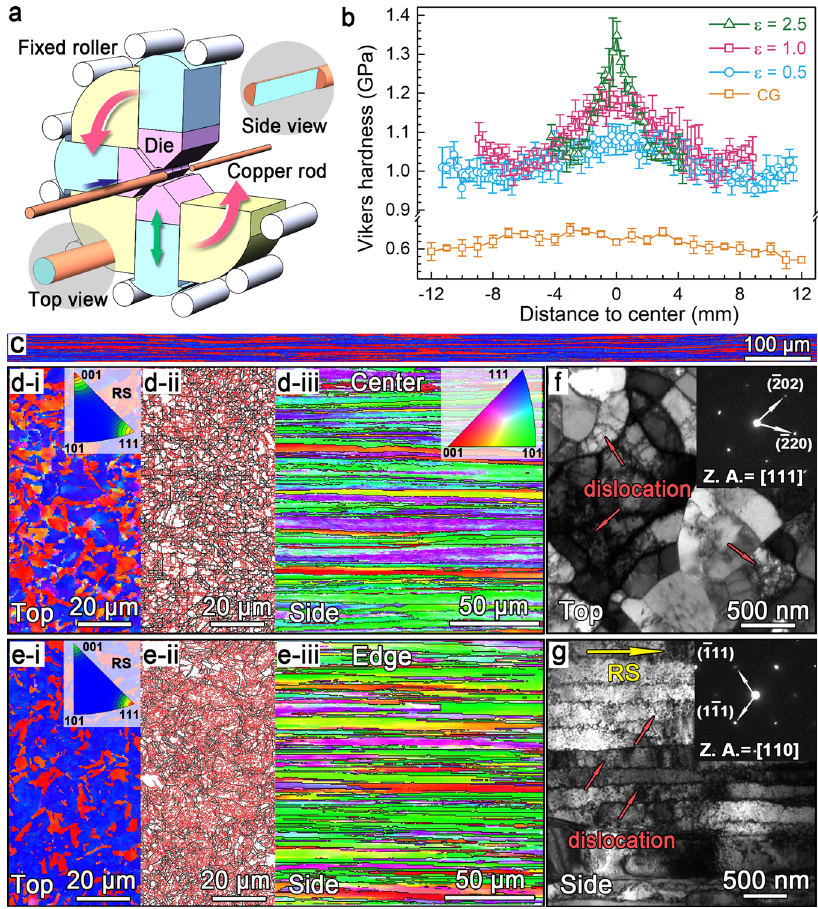
Fig. 2 Processing, micro-hardness and microstructures of the swaged copper. a Schematic illustration of rotary swaging technique. b Vickers micro- hardness measured from center to edge along the radial direction (the error bar represents the standard deviation of hardness). c EBSD crystal orientation map ( fi lled with orientation information of cross section) with ε = 2.5. d , e EBSD crystal orientation maps and GB maps in the rod center ( d -i, d -ii, d -iii) and at the edge (e-i, e-ii, e-iii) with ε = 2.5 from top ( d -i, d -ii, e -i, and e -ii) and side ( d -iii and e -iii) views. The insets are inverse pole fi gures and color code, respectively. Black and red lines in d -ii and e -ii represent high angle GBs (>15°) and low angle GBs between 2° and 15°, respectively. f , g TEM ima g es of the swaged copper with ε = 2.5 from top ( g ) and side ( h ) views. The insets are selected area electron diffraction (SAED)